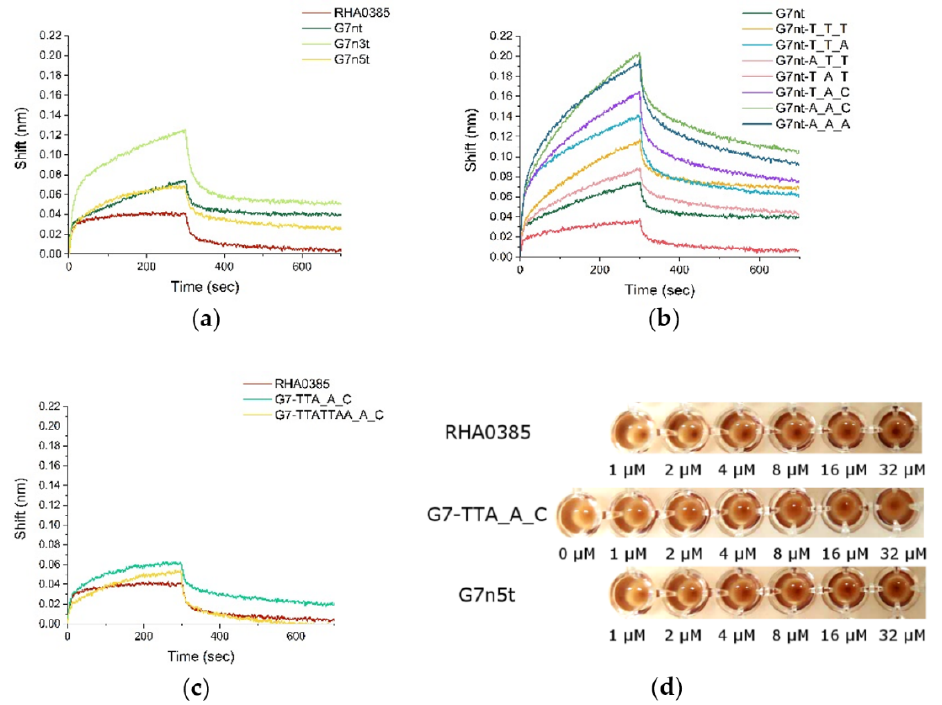
Figure 3. Aptamer binding vHA measured by BLI (concentration of vHA was set as to 14 nM): ( a ) RHA0385 and aptamers with flanking sequences truncated; ( b ) G7nt and aptamers with single-nucleotide loops; ( c ) RHA0385 and aptamers with major loop altered. ( d ) Hemagglutination inhibition assay of 3.6 nM vHA with RHA0385, G7-TTA_A_C and G7n5t at different concentrations.